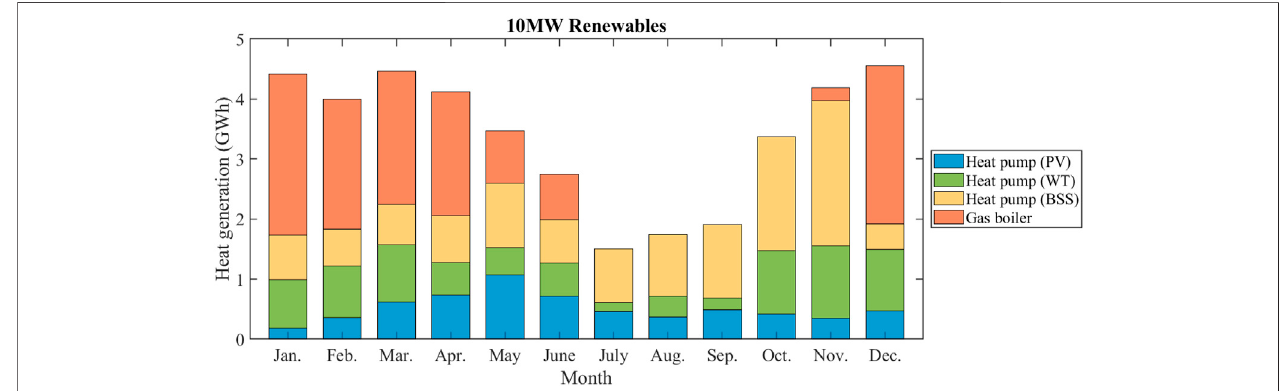
FIGURE 4 | Example of monthly heat generation from renewables and gas boiler.